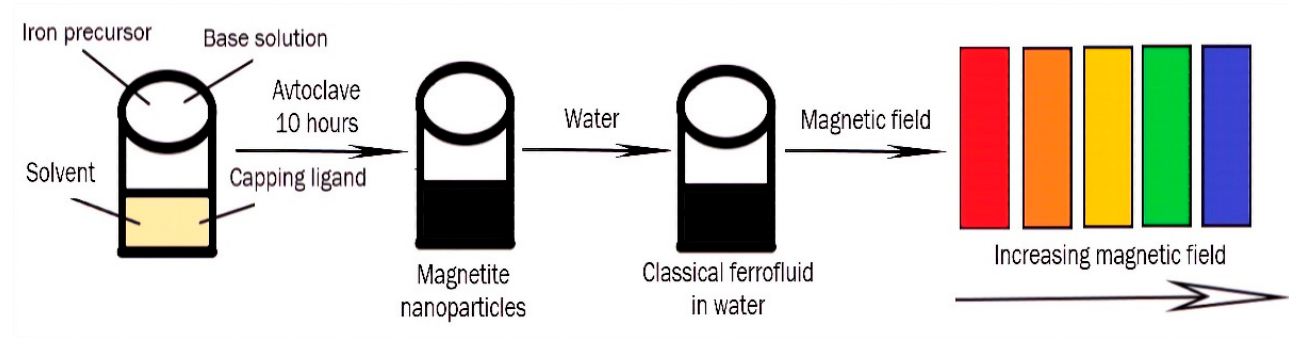
Figure 12. Application of magnetic ferrofluids for the preparation of photonic materials.